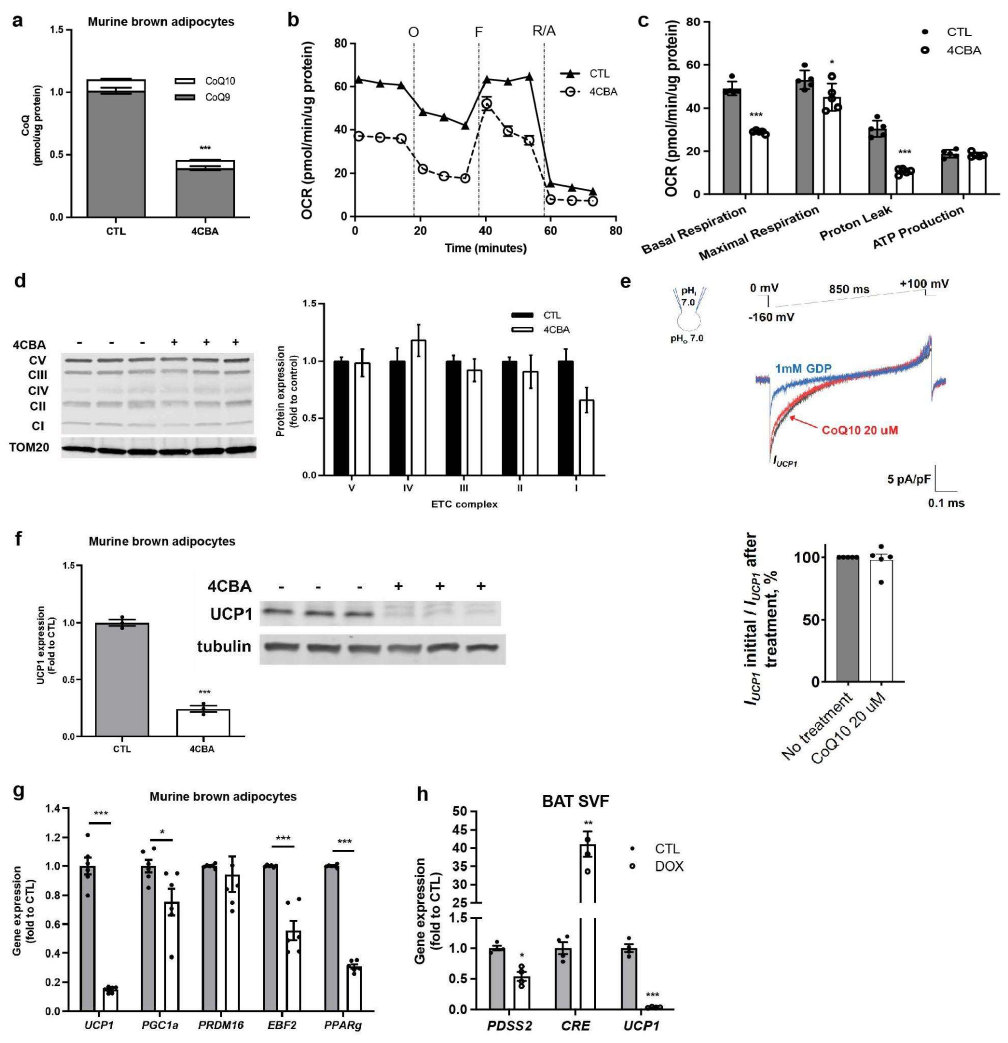
Figure 1. CoQ deficiency affects BAT mitochondrial respiration and UCP1 level. ( a ) Coenzyme Q (CoQ) levels in murine brown adipocytes were decreased after treatment with 4-chlorobenzoic acid (4CBA) compared to vehicle (CTL), n = 3. ( b , c ) Oxygen consumption rate (OCR) was measured in control, and 4CBA treated cells, using seahorse XFe24 analyzer and components of mitochondrial respiration were analyzed, n = 5. Basal, maximal, and proton leak OCR were decreased in 4CBA-treated cells compared to CTL. ( d ) Mitochondrial complexes isolated from brown adipocytes were measured by western blot, n = 3. Expression was unchanged between CTL and 4CBA-treated cells. Each lane in the western blot pictured is one independent sample. ( e ) Upper panel: Representative UCP1-dependent H+ current recorded from whole brown fat mitoplasts before (black) or after CoQ 10 treatment (20 μM). 1 mM GDP (blue) was used as an inhibitor of UCP1 activity. Lower panel: UCP1-dependent H+ current densities in the inner mitochondrial membrane (IMM) of brown fat after CoQ 10 treatment compared to UCP1-dependent H+ current before treatment, n = 5. No differences were observed in H+ current densities between CTL and CoQ 10- treated samples. Mean ± SEM. ( f ) UCP1 protein expression in murine brown adipocyte cells, measured by western blot, was decreased in 4CBA-treated cells compared to CTL, n = 3. ( g ) Thermogenic genes were measured by reverse transcription polymerase chain reaction (rtPCR), n = 6. UCP1 gene expression was decreased in 4CBA-treated cells. ( h ) Stromal vascular fraction (SVF) was isolated from brown adipose tissue (BAT) of PDSS2FL animals, and PDSS2 was knockout by the induction of cre recombinase with doxycycline. Gene expression was measured by rtPCR, n = 4. PDSS2 and UCP1 gene expression was decreased while Cre expression was increased. Data are mean ± SEM. Significance presented at * p < 0.05, ** p < 0.01, and *** p < 0.001 compared to controls or otherwise